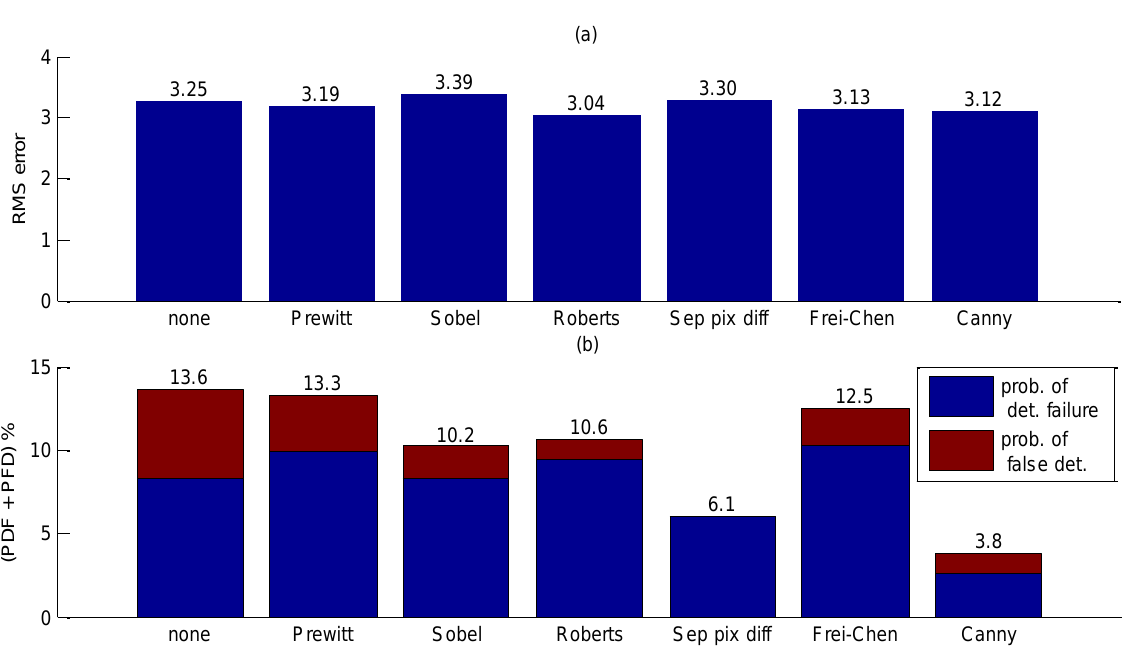
Figure 10. Accuracy performance results for selected spatial filters. ( a ) RMS error results. ( b ) Probability of false detection and detection failure